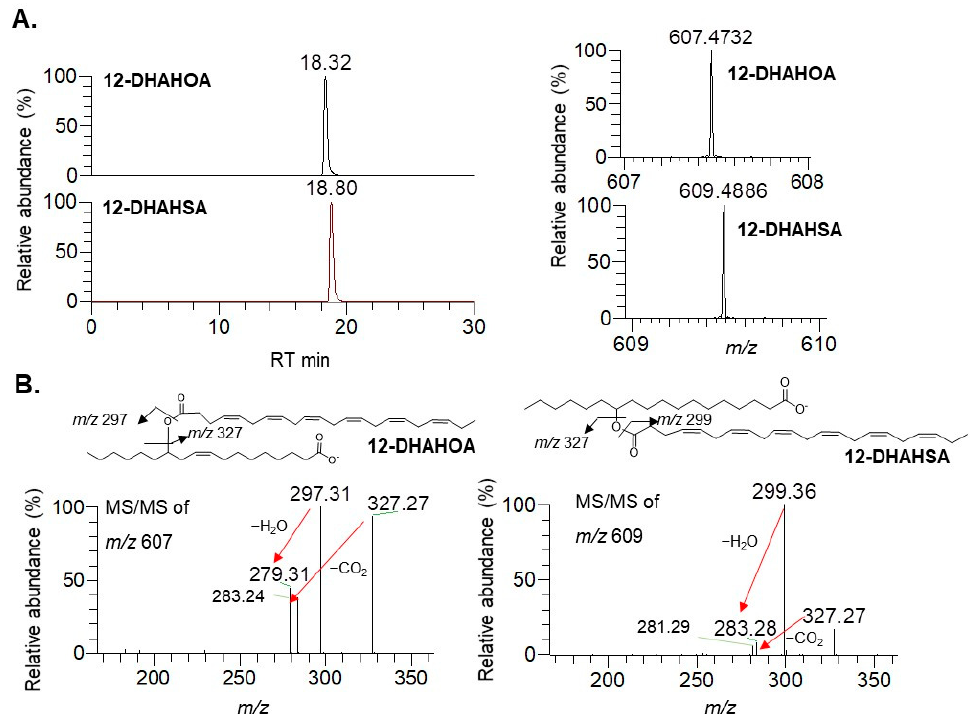
Figure 1. Structural characterization of DHA-derived FAHFAs. ( A ) Extracted ion chromatograms of 12-DHAHOA, 12-DHAHSA (left panel), and their respective high-resolution mass spectra (right panel). ( B ) MS/MS spectra of 12-DHAHOA and 12-DHAHSA.